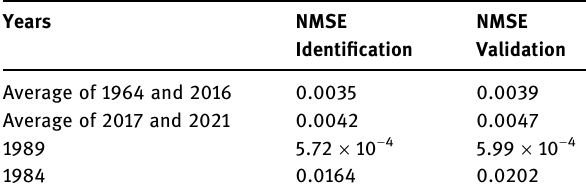
Table 1: Summary of results of the identi fi cation experiment Years